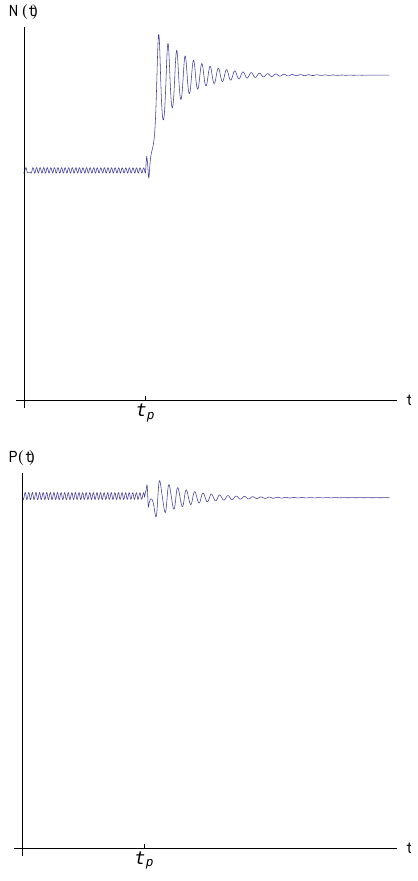
Fig. 18. Stabilization of a predator-prey system after a large perturbation in the case of a limit cycle and a stable internal